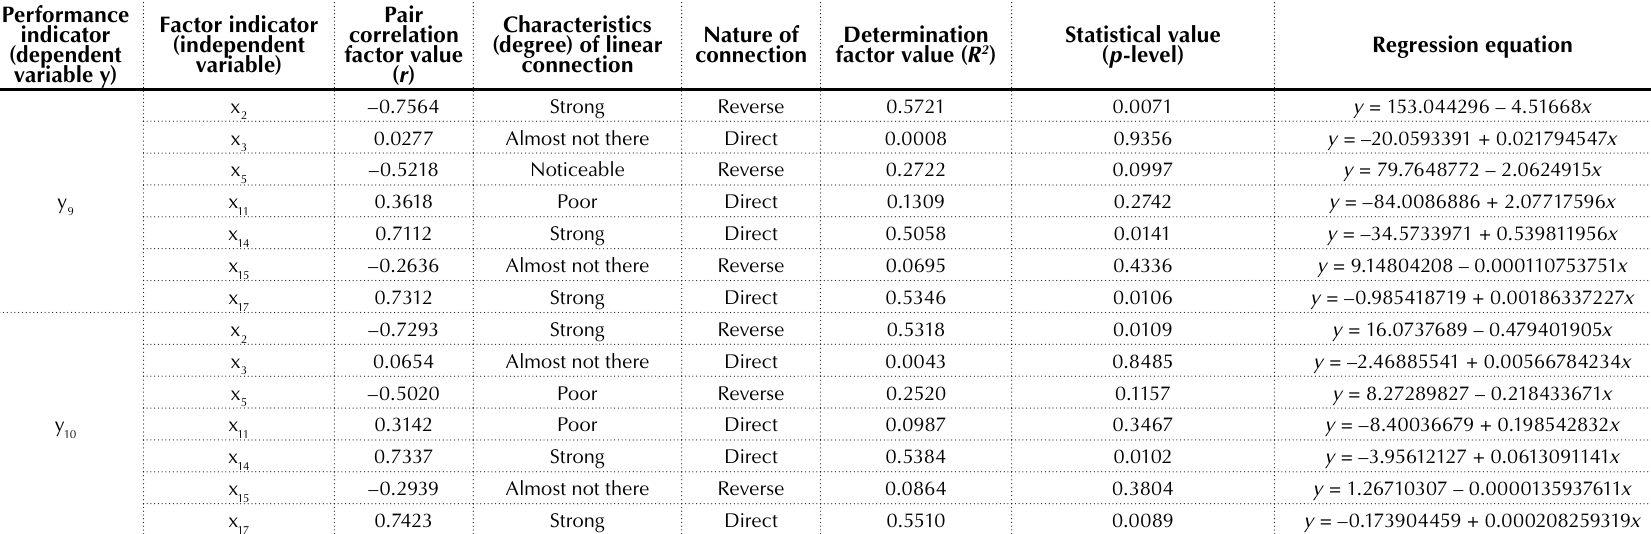
Table 4A (cont.). The nature and value of influence of foreign banking indicators (factors) on the indicators of financial and economic security of Ukraine (indicators under